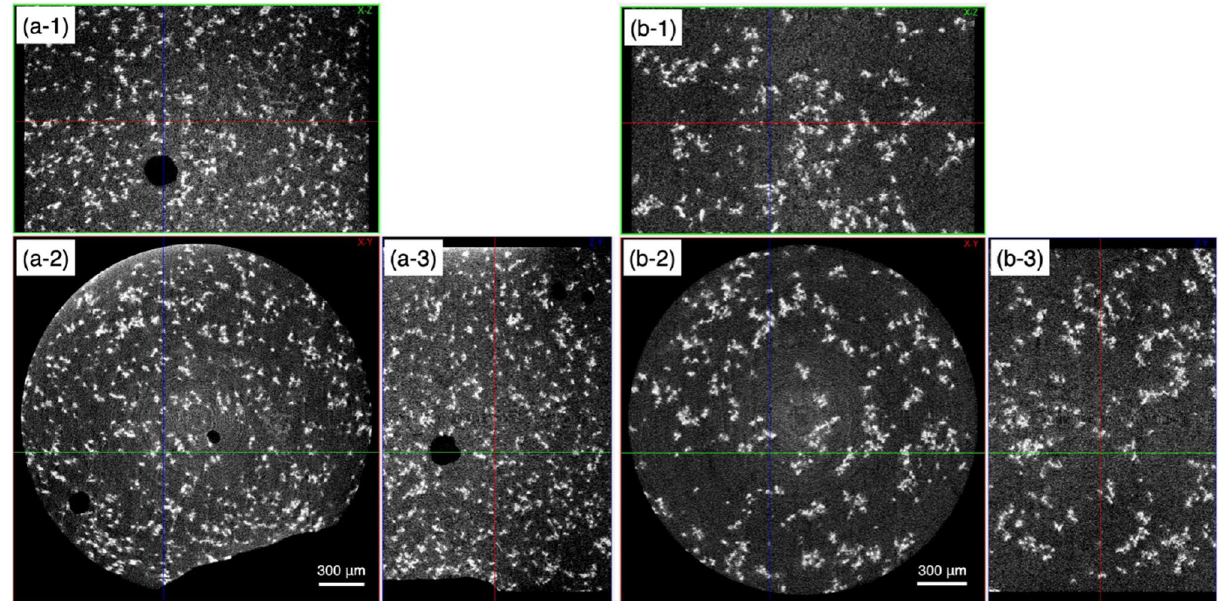
Figure 4. Micro-CT images of the same samples as those used for SEM observations. The white crystals are Fe-Ti oxide, the background is melt/glass and plagioclase. ( a ) Unaged sample with t pr = 10 min and ˙ γ pr = 0 s −1 . ( b ) Shear-aged sample with t pr = 60 min and ˙ γ pr = 0.02 s −1 . ( a-1 ) and ( b-1 ) are sagittal planes and ( a-3 ) and ( b-3 ) are coronal planes composed of 1531 images each. ( a-2 ) and ( b-2 ) are transverse